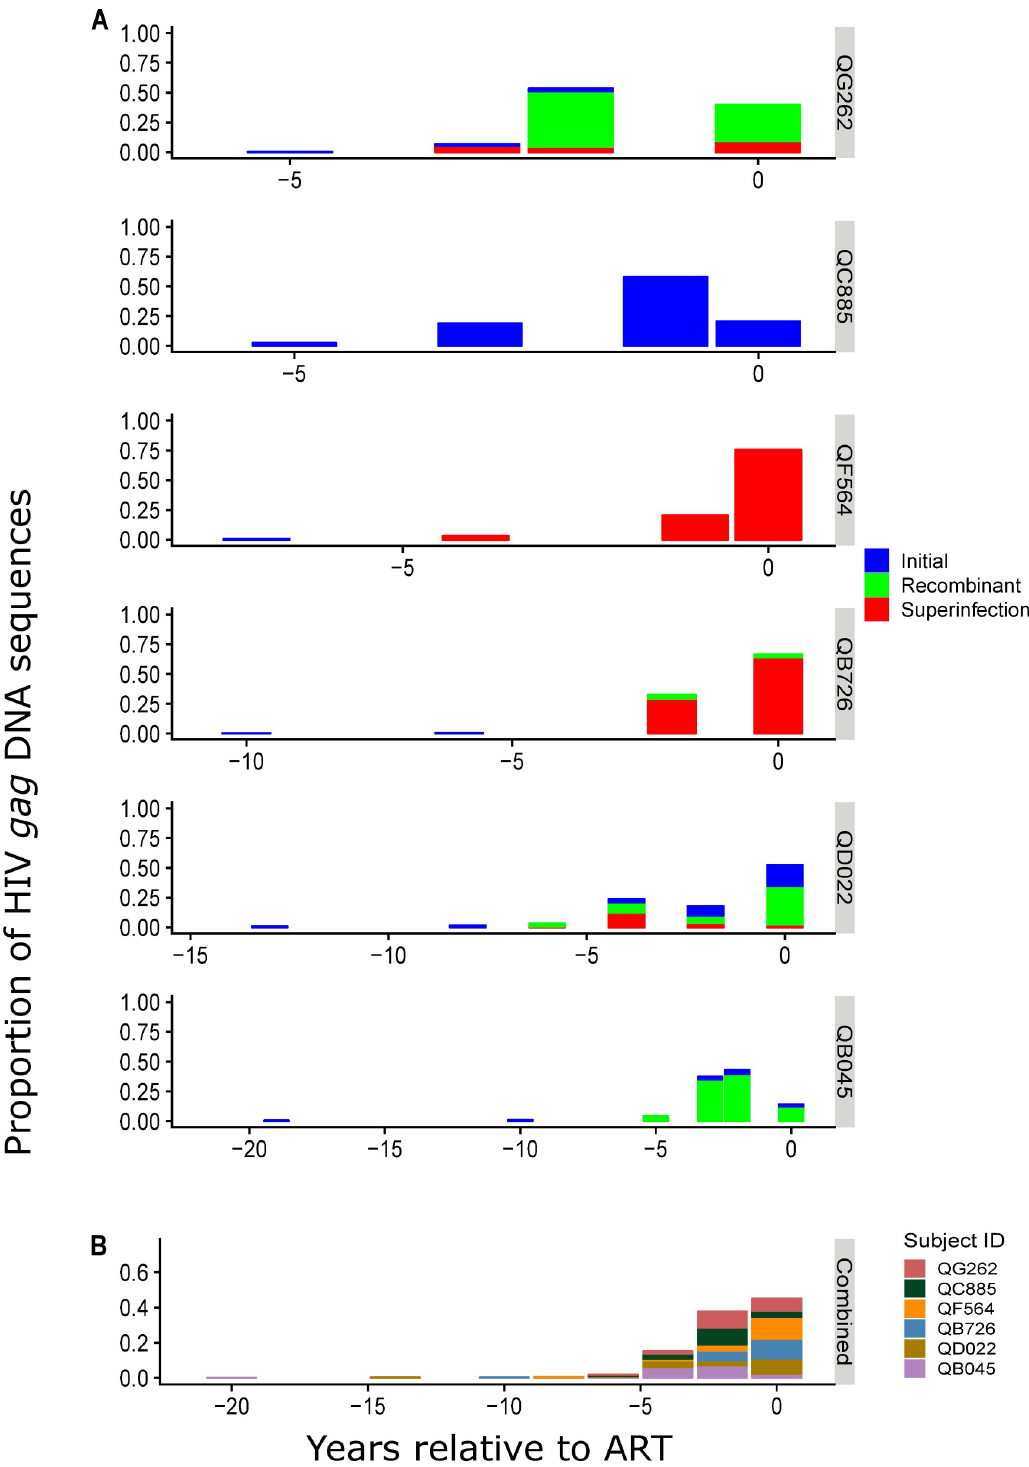
Fig 4. Estimated seeding time of HIV gag DNA reservoir sequences in relation to ART initiation. (A) Proportions of the HIV gag DNA reservoir sequences at estimated times of seeding prior to ART initiation as determined by the smallest pairwise distance between the HIV gag DNA sequences and longitudinal pre-ART HIV gag RNA sequences for each subject. Blue denotes virus from the initial infection lineage, red denotes superinfecting virus lineage, and green denotes within- gag recombinants. (B) Proportions of HIV gag DNA sequences grouped into the nearest 2-year interval from all 6 participants combined. Colors denote individual subjects according to the